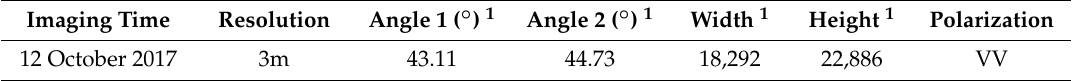
Table 5. The detailed information of the Cosmo-SkyMed image.